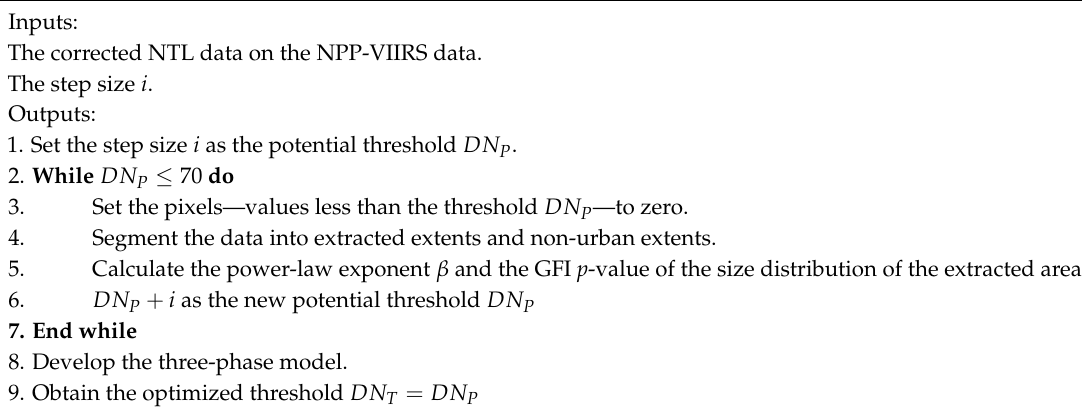
Algorithm 1 Algorithm for optimizing the